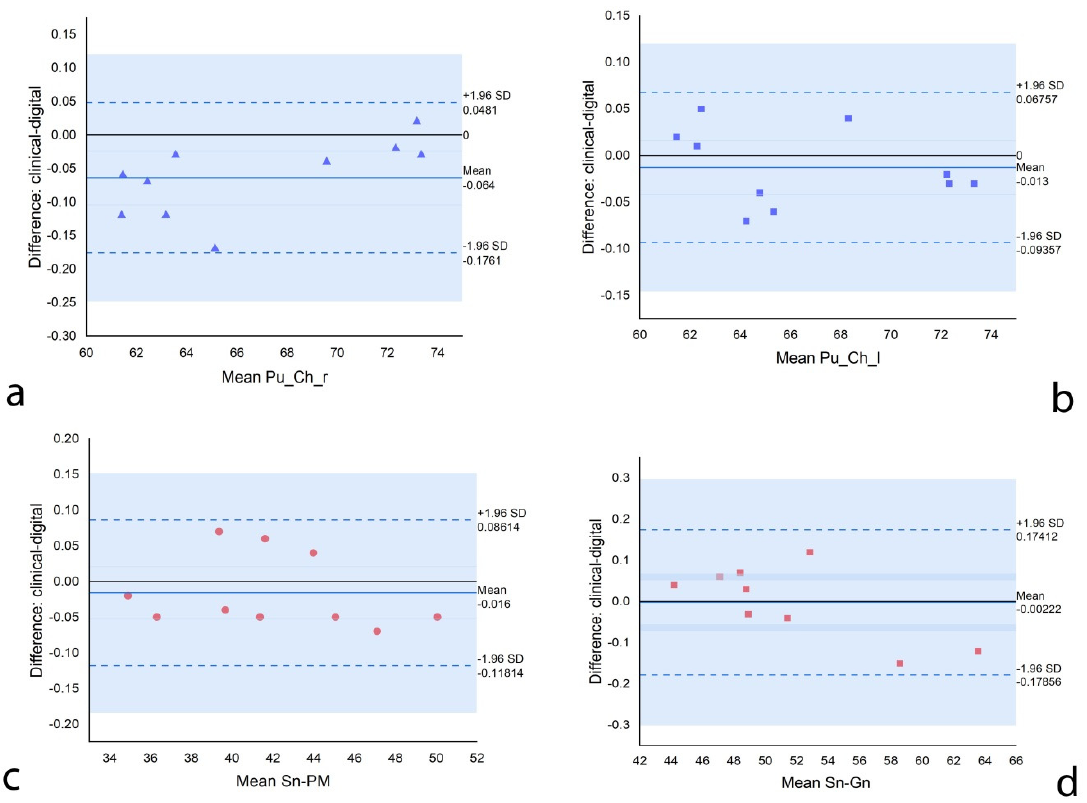
Table 1. Descriptive data of the variables calculated from the clinical cephalometric analysis.